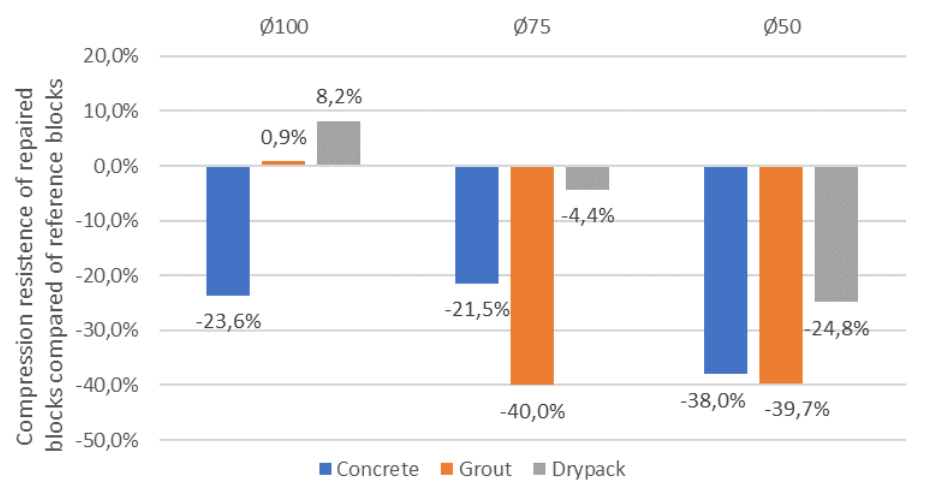
Figure 6 – Compression resistance of repaired blocks compared to reference